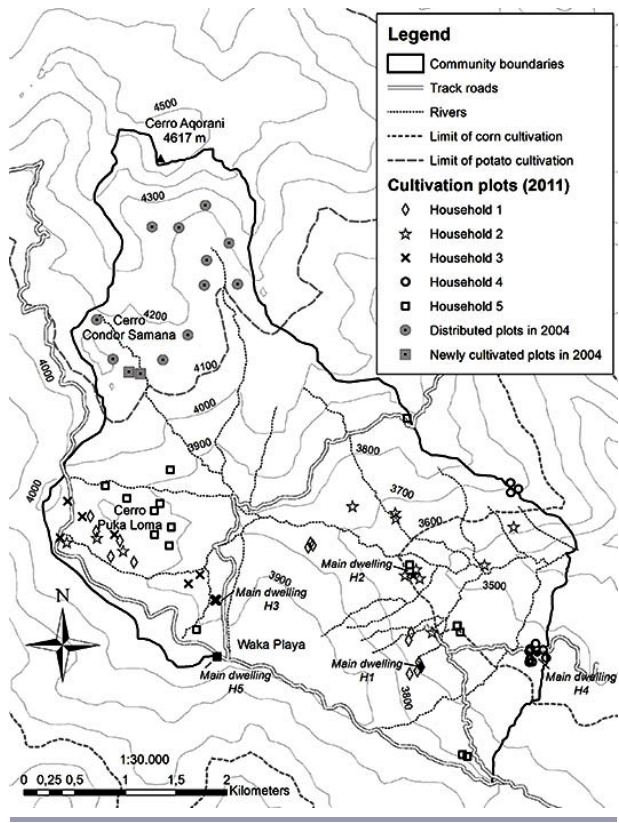
Fig. 2 . Location of cultivation plots in